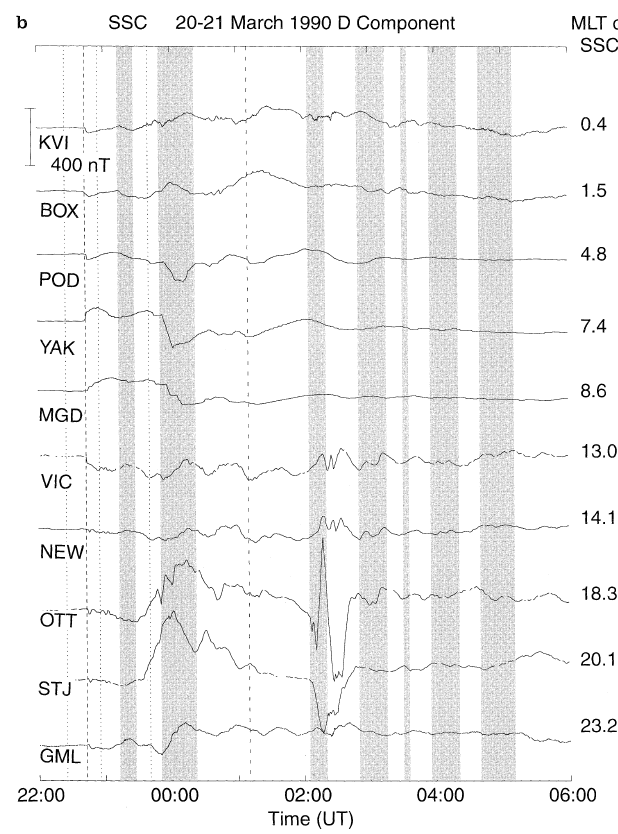
European stations are also shown (– – – – – ) in addition to expansion phase onsets determined from LANL particle data ( (cid:225) (cid:225) (cid:225) (cid:225) (cid:225) ). Where multiplehaveonsetsoccurred, shadedbars areusedtoindicatetherange of onsets. The magnetic local time is stated for each station at the time of